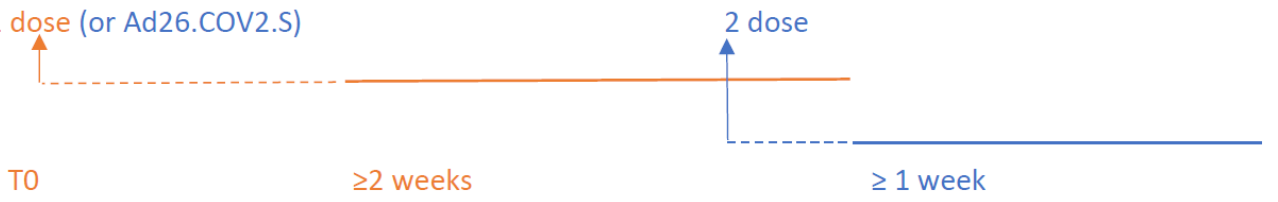
Figure 1. Experimental group follow-up: the dashed lines following the first and the second dose administration represent the induction time. The solid lines display the follow-up period considered in the analysis. Cases occurred within 14 days after the first dose uptake were not included. Cases occurred within one week from the second dose administration were attributed to the first dose effect. The length of the induction time for the Ad26.COV2.S vaccine was set at 14 days after the single dose administration (details in the text).